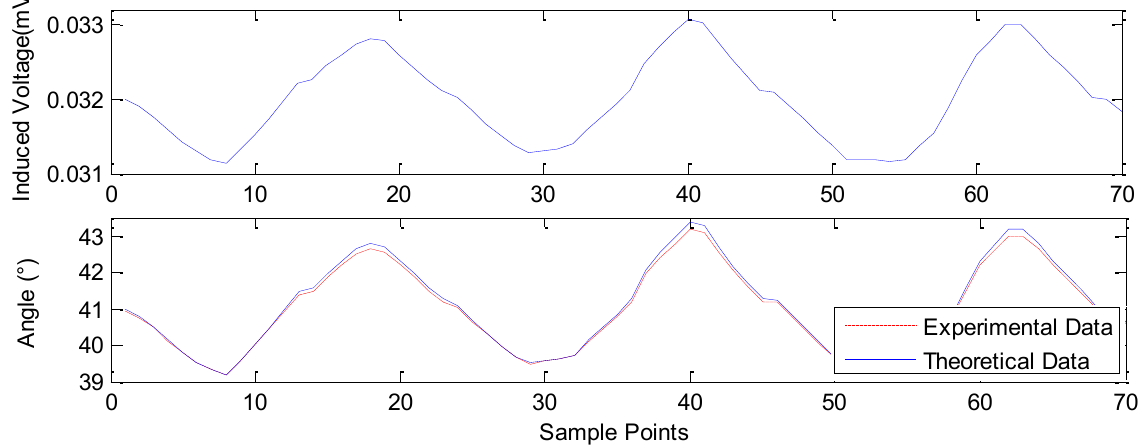
Figure 15. The sensing effect for small angle